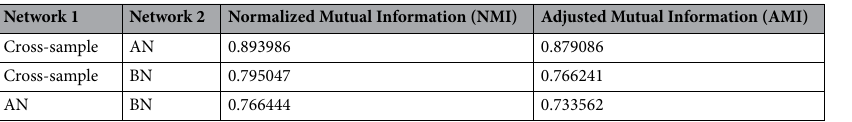
Network 1 Network 2 Normalized Mutual Information (NMI) Adjusted Mutual Information